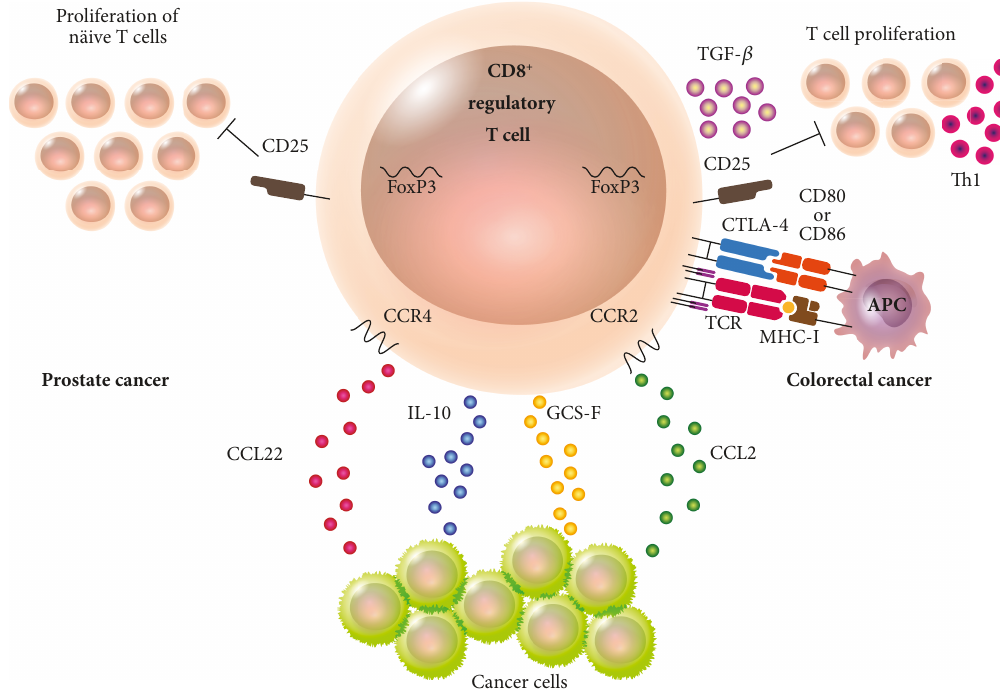
Figure 4: Participation of CD8 + Treg lymphocytes in cancer. Regulatory T lymphocytes often aid in the evasion of the immune system by the cancer cell. Speci fi cally, CD8 + Tregs can be induced in tumor tissue due to the presence of cytokines as GCS-F and IL-10. They can also be attracted to the tumor after the latter releases the chemokines CCL2 and CCL22 that attract regulatory lymphocytes expressing CCR2 and CCR4. In colorectal cancer, CD8 + CD25 + FoxP3 + Treg lymphocytes with an immunosuppressive phenotype characterized by expressing CTLA-4 and TGF- β inhibit Th1 lymphocyte proliferation. In prostate cancer, CD8 + CD25 + FoxP3 + Treg lymphocytes have been found to share markers with colorectal cancer and can inhibit naïve T lymphocyte